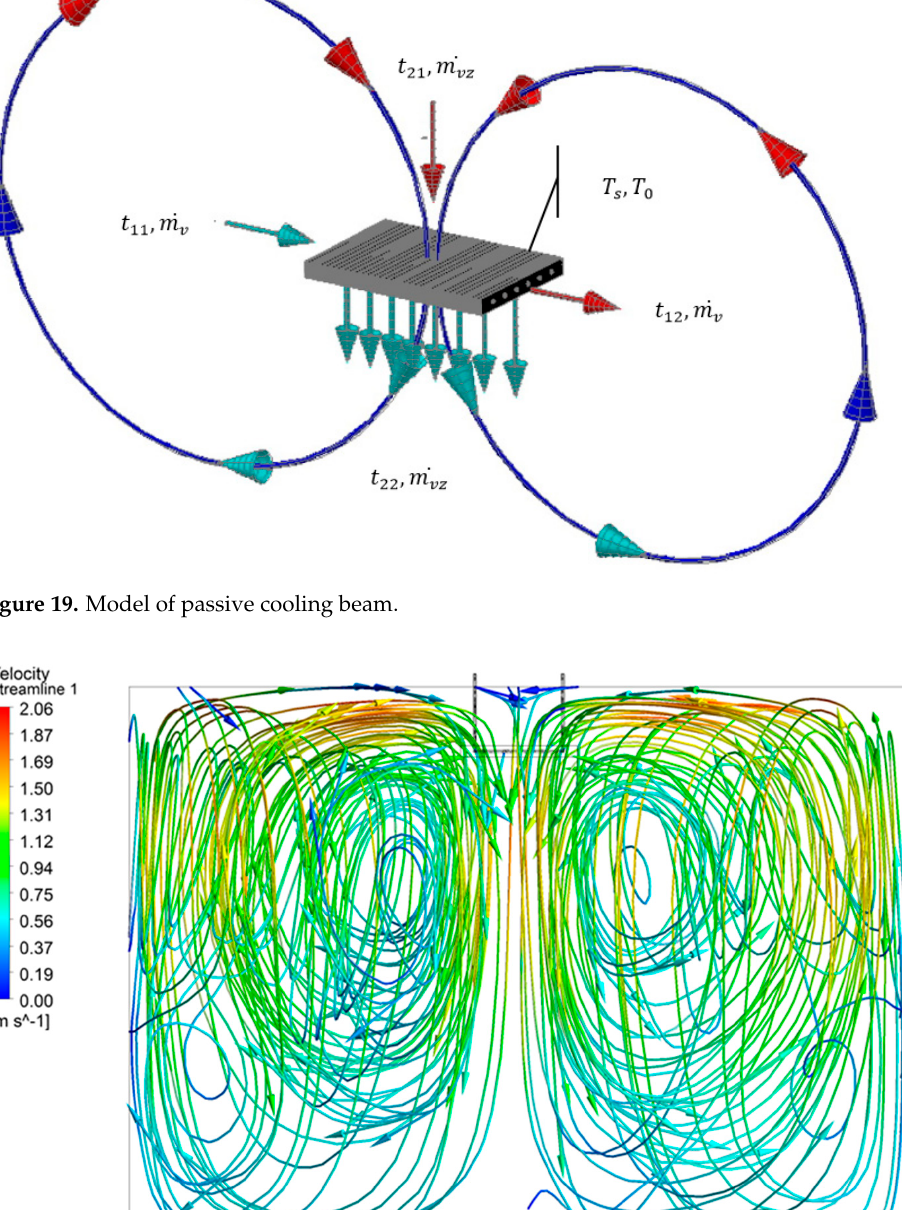
Figure 21. Model of passive cooling beam—the contours of temperature (°C).